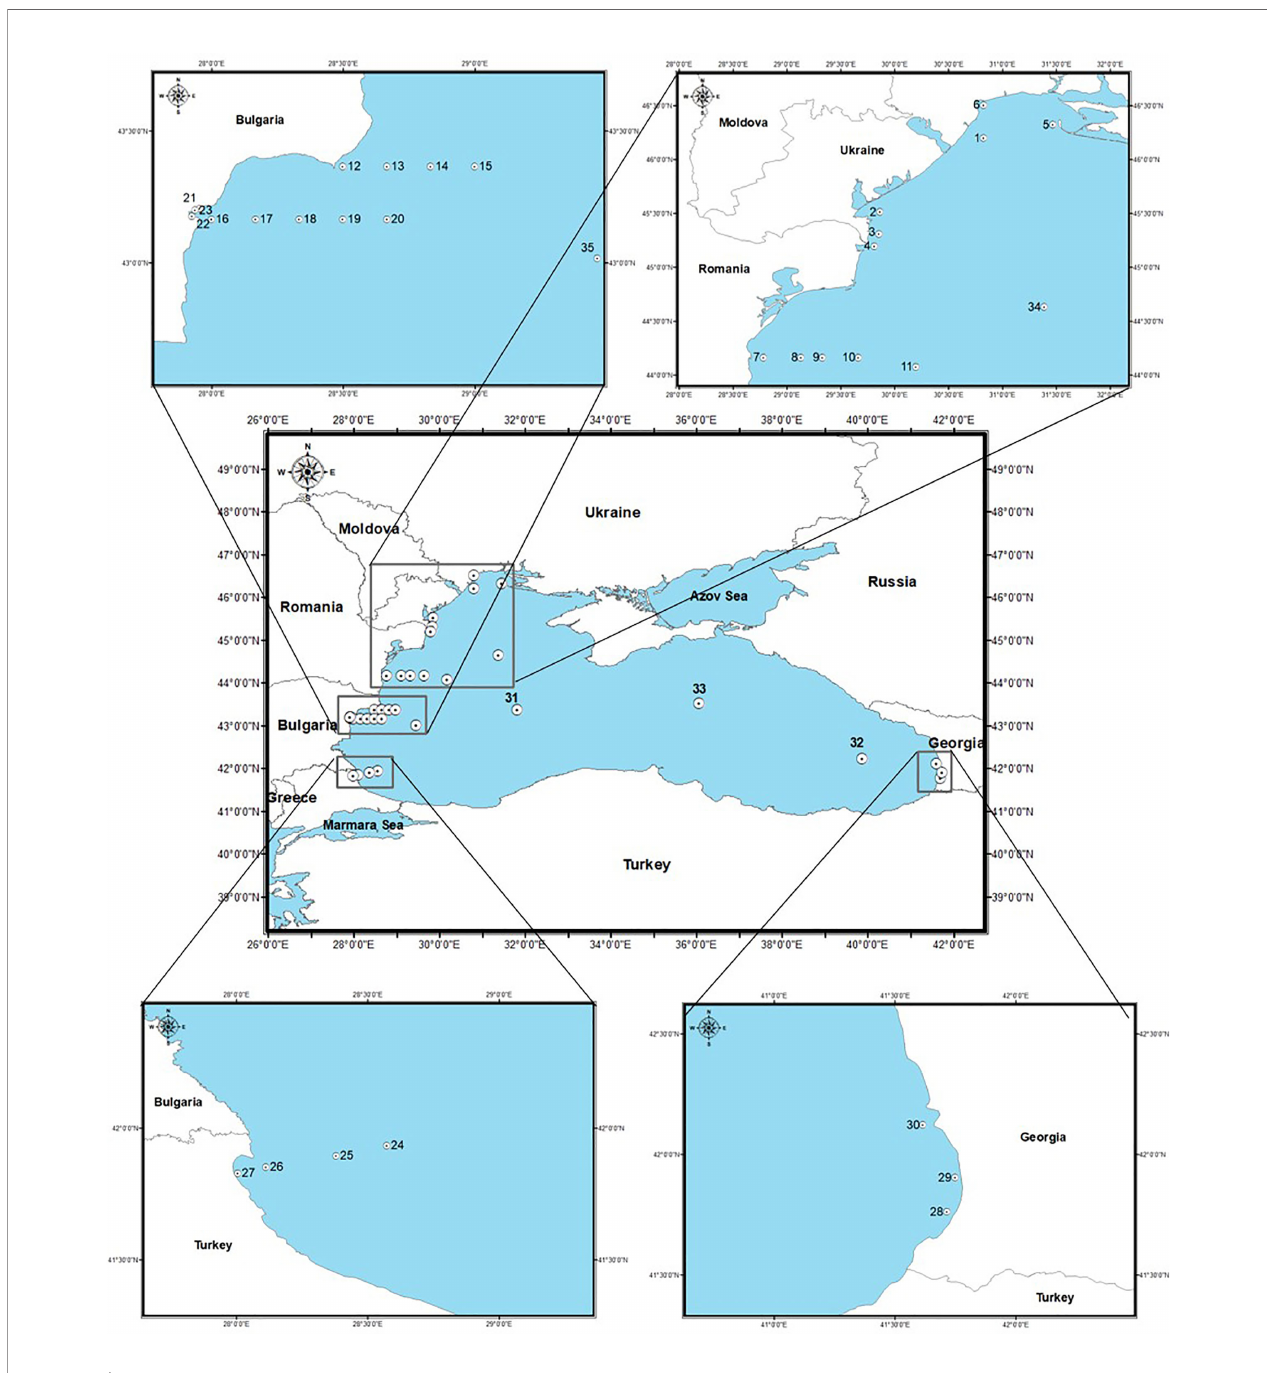
FIGURE 1 | Map of sampling sites and location of stations in the Black